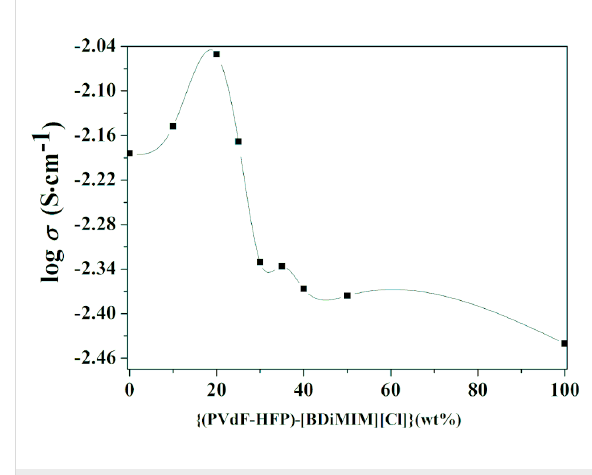
Figure 3: Room-temperature electrical conductivity of the polymer/ ionic liquid blend as a function of the ionic liquid concentration.